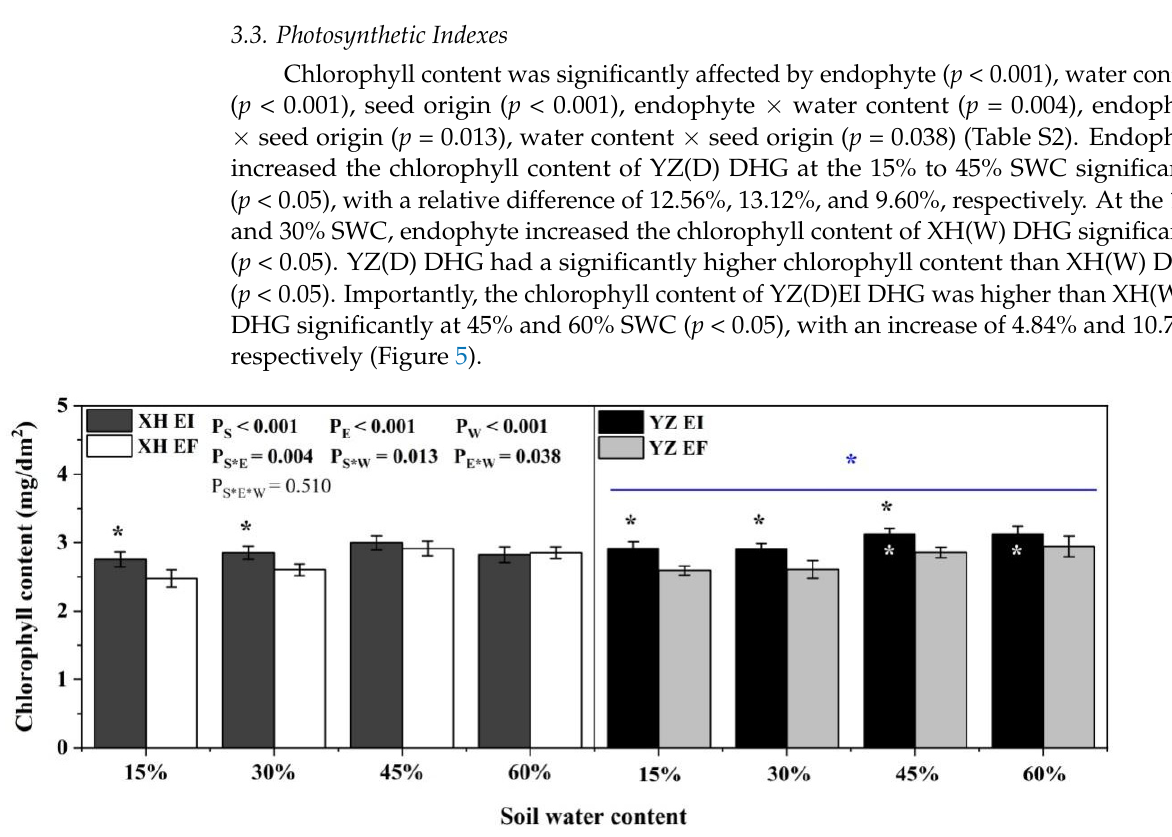
Figure 4. The CtK content of A. inebrians seedlings shoots and roots from XH(W) and YZ(D) seeds under various soil water content (ng/g). Upwards and downwards bars represent the value of shoot and root part, respectively. The asterisk (*) above/below error bars means significant difference ( p < 0.05) between EI and EF under the same soil water content. White/black * in the white, black and gray bars indicates significant difference ( p < 0.05) between Xiahe and Yuzhong maternal habitat type of EF/EI grasses. The blue * above/below full blue line indicates significant difference ( p < 0.05) between Xiahe and Yuzhong maternal habitat type.